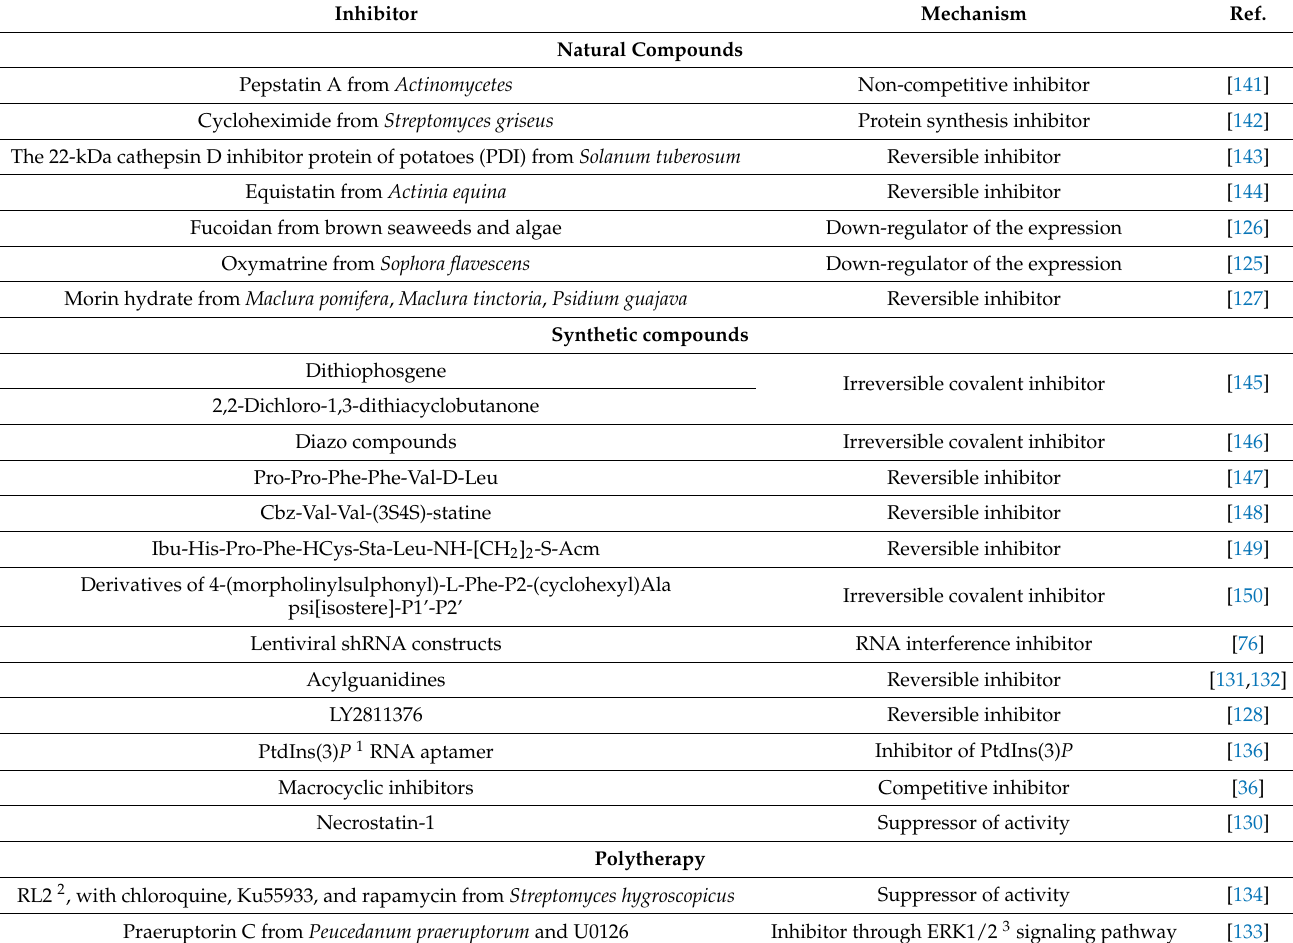
Table 2. Cathepsin D inhibitors in chronological